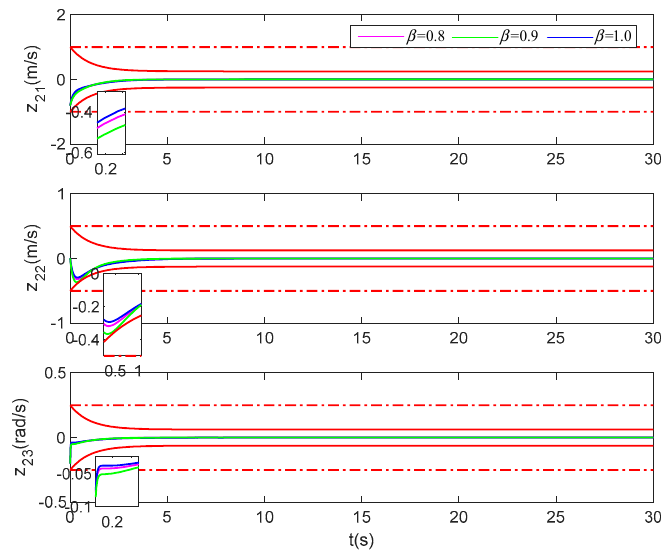
Figure 15. Velocity tracking error of the vessel with different orders.